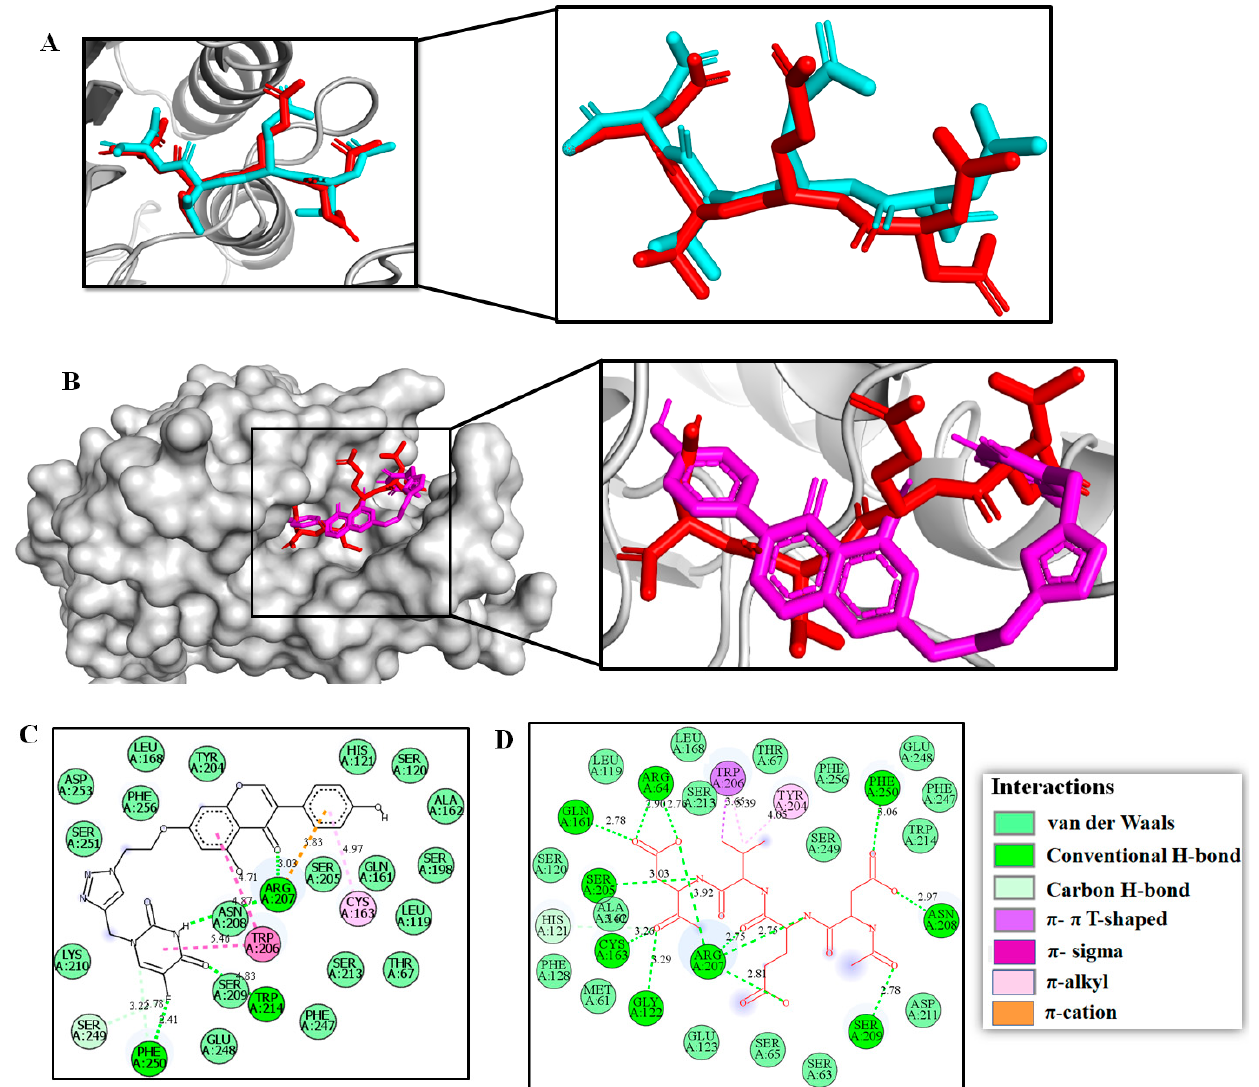
Figure 9. Docking studies of 4a-caspase-3 complex. ( A ) Self-docking study. 3D superposition of the best-docked pose of Ac-DEVD-CMK (in cyan) and its crystallographic binding pose (in red). ( B ) Alignment of the best docked conformation of 4a (in magenta) and crystallographic binding mode of Ac-DEVD-CMK (in red) within the caspase-3 catalytic domain. ( C ) 2D interaction diagram between 4a and caspase-3. ( D ) 2D interaction diagram between inhibitor Ac-DEVD-CMK and caspase-3.